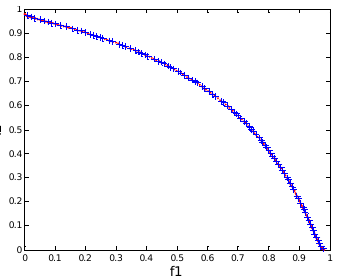
Fig. 5. Pareto fronts produced by KMOPSO for